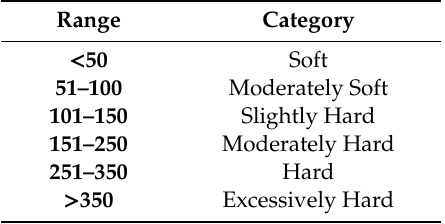
Table 8. Water quality classification according to various ranges of hardness [57].